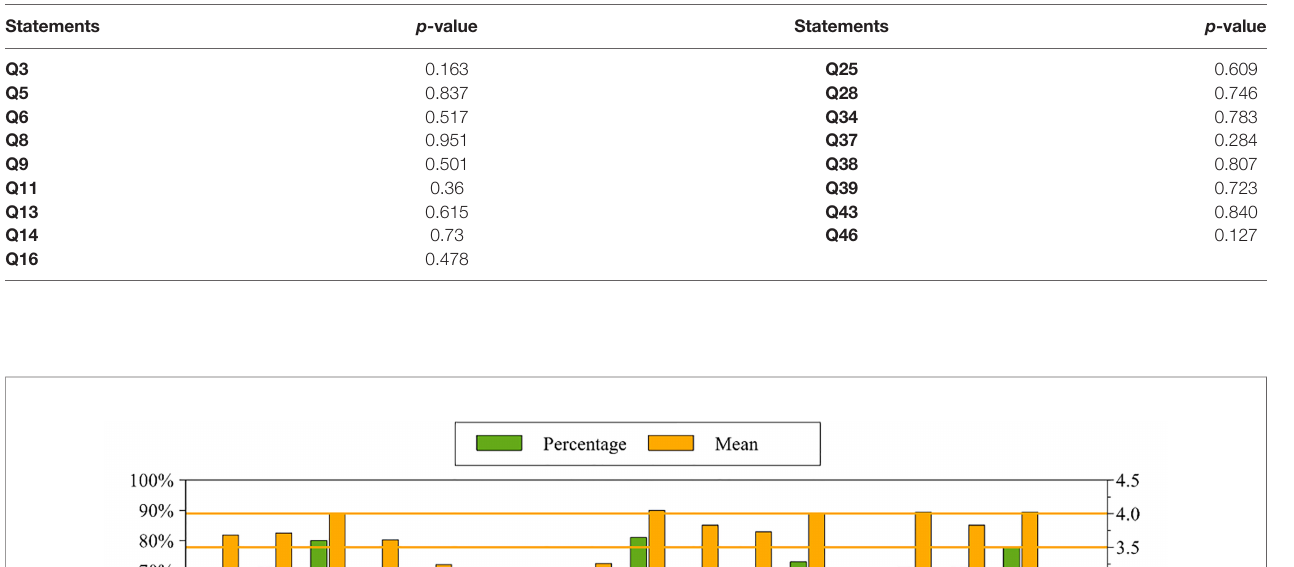
TABLE 4 | p -value of the Wilcoxon signed rank test.